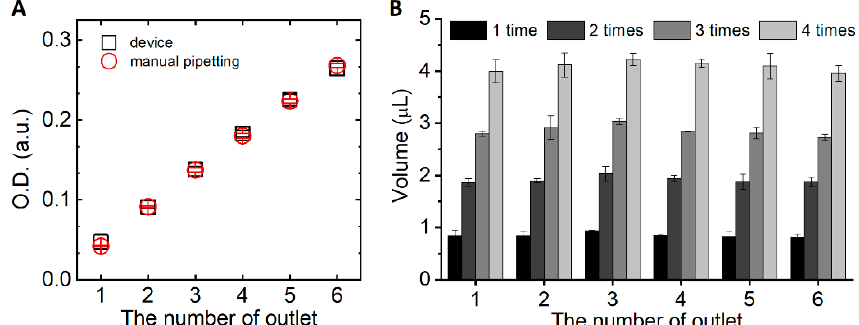
Figure 3. Estimation of concentration gradient generation. ( A ) The optical density of the dispensed solutions from each outlet was compared between the manual pipetting method and the finger-actuated concentration gradient generator. The error bars represent the standard deviation of three replicates. ( B ) The dispensed volume from each outlet was compared with respect to the number of the pushing times. The error bars represent the standard deviation of three replicates.